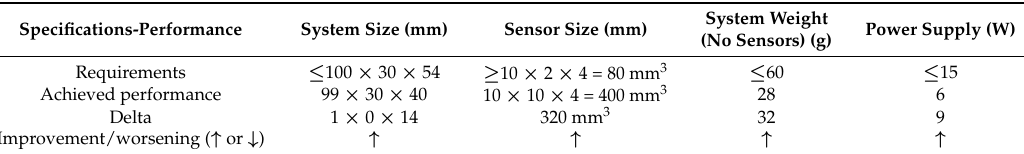
Table 5. Performance vs. specifications.